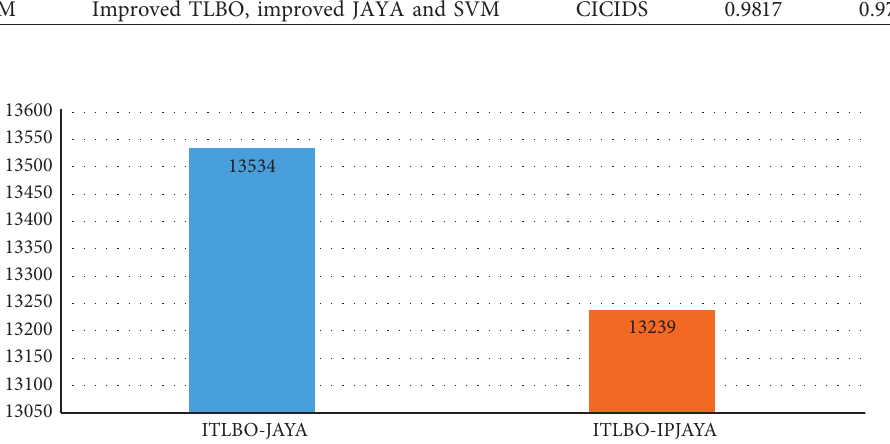
Figure 15: Execution time comparison for the NSL-KDD